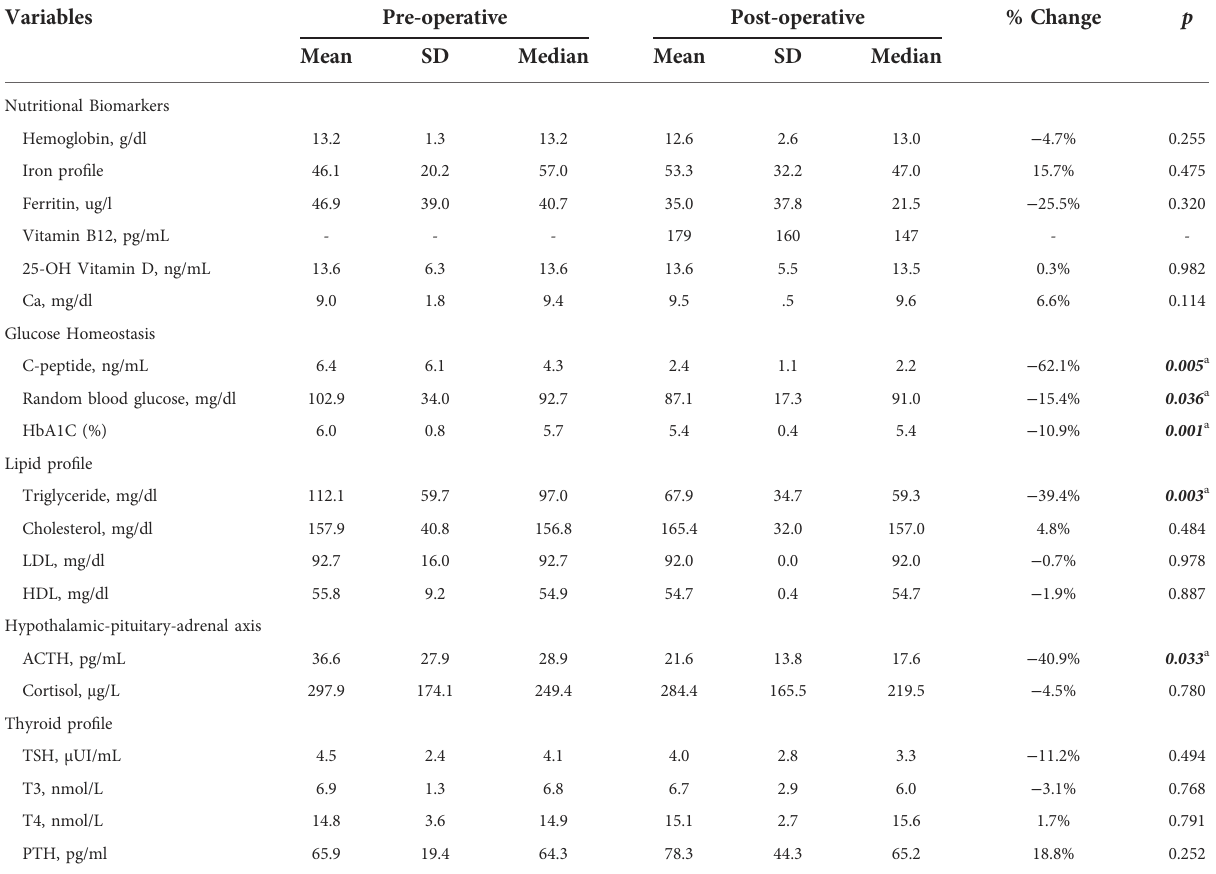
TABLE 2 Blood biochemistry of study participants before and after laparoscopic sleeve gastrectomy.